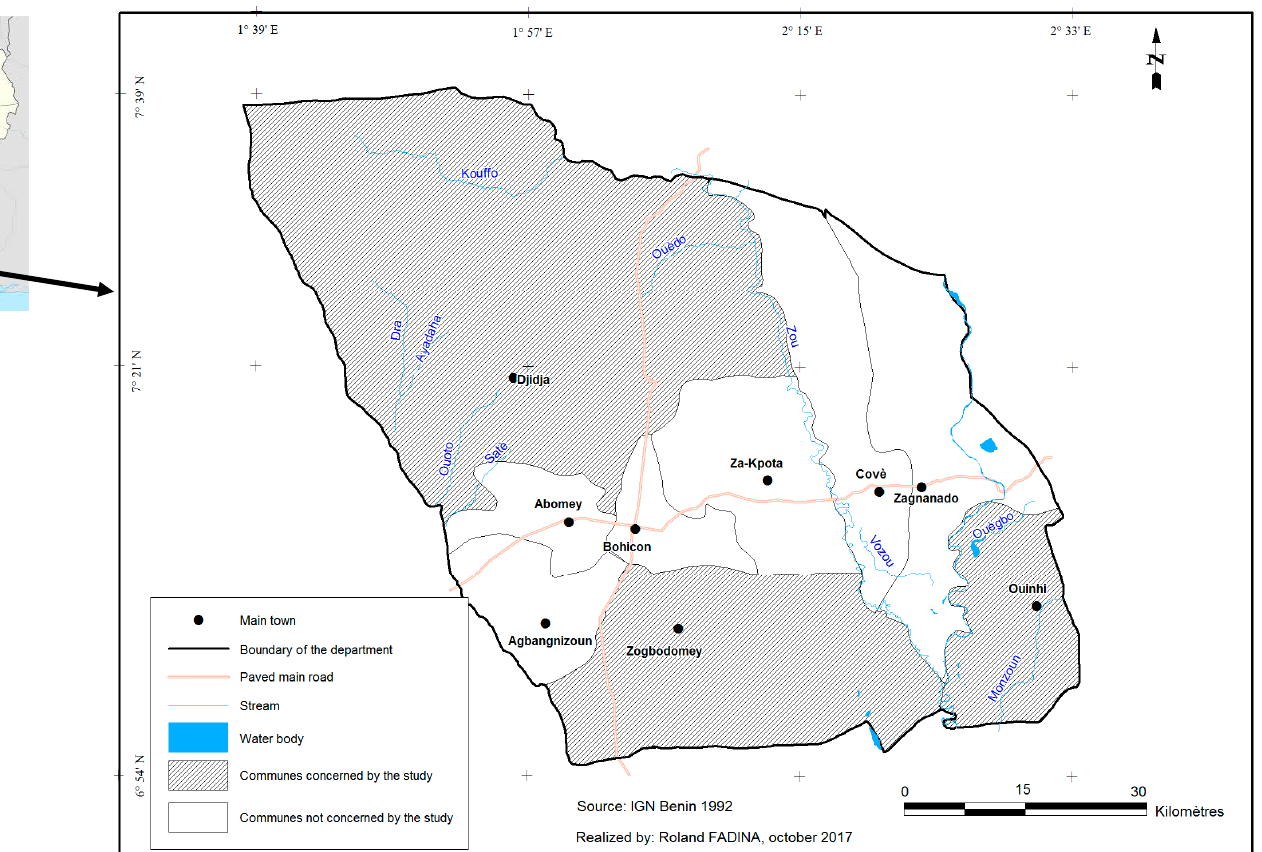
Figure 1. Map of the Zou Department, the study Figure 1 . Map of the Zou Department, the study area.